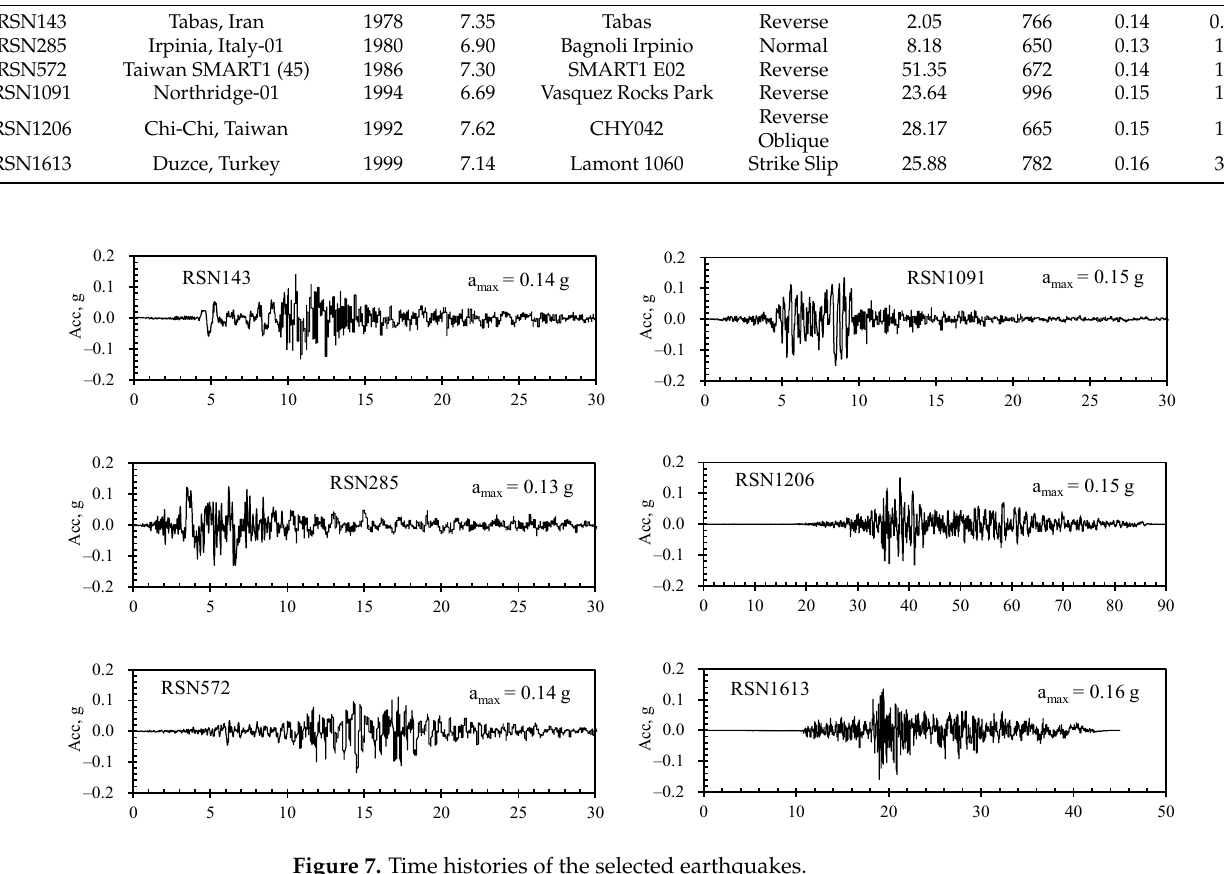
Figure 7. Time histories of the selected earthquakes.